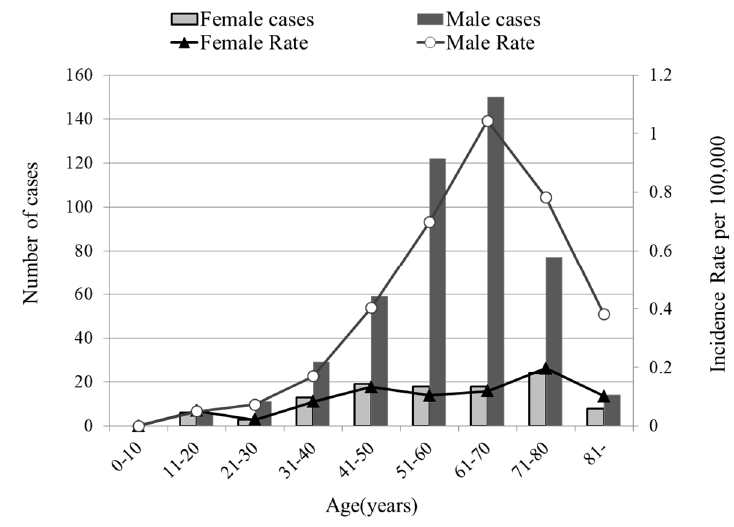
Figure 1. Number of new cases per age group according to age-specific incidence rates per 100,000 population.